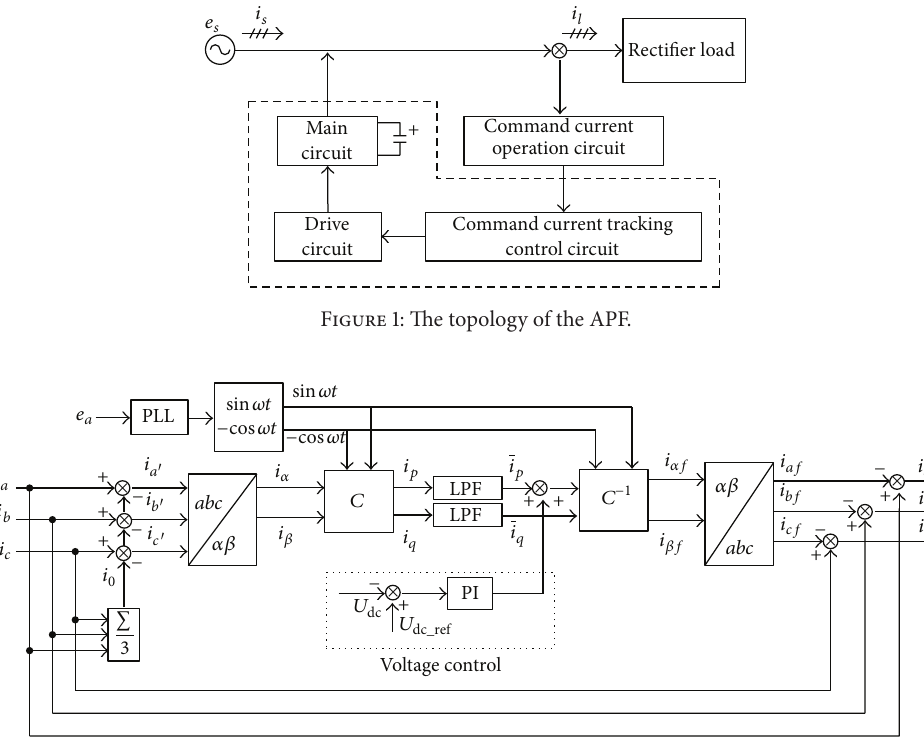
Figure 2: The diagram of harmonic current